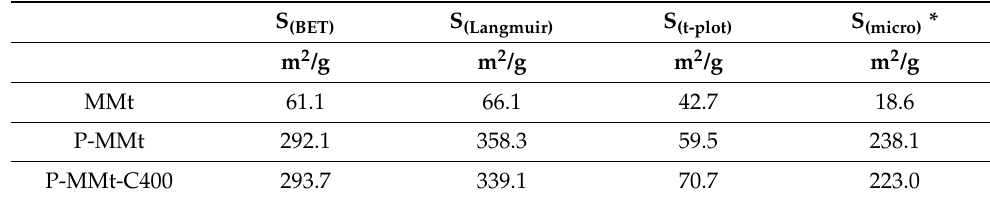
Figure 3. The effect of the calcination temperature on the SSA of P-MMt (no calcination at the first point). Table 3. The textural properties of MMt, P-MMt and P-MMt-C400.